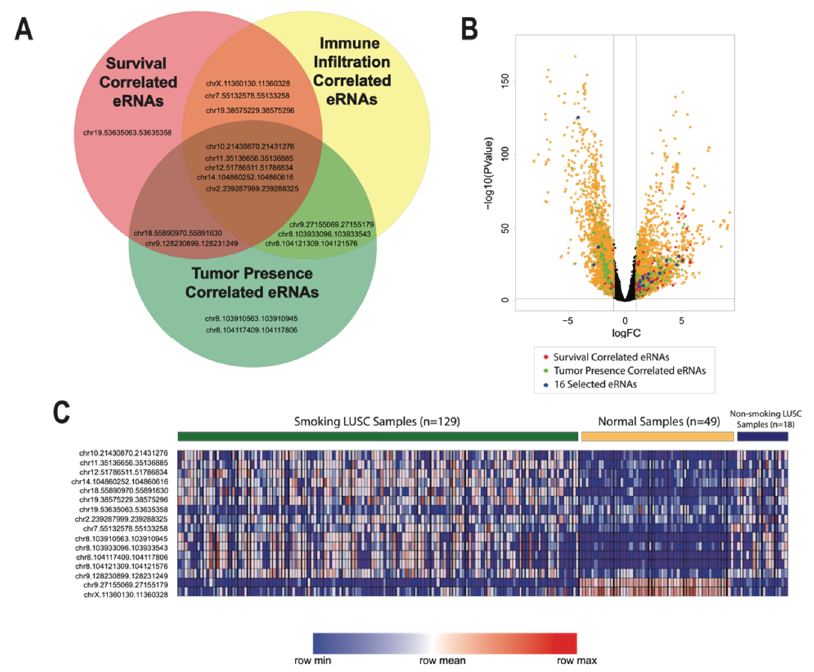
Figure 4. Identification and Analysis of 16 eRNAs identified to be critical to LUSC immune landscape and tumor phenotype. ( A ) Venn diagram summarizing the significant correlations of the selected 16 key eRNAs to patient survival, immune cell infiltration, and tumor status. Each of the 16 selected eRNAs has a high degree of association with various clinical and molecular measures of tumor severity, implicating their potential role in furthering LUSC pathogenesis and metastasis. ( B ) Volcano plot across all significantly dysregulated eRNAs illustrating the statistical significance versus the magnitude of change (log fold change) in survival-correlated eRNAs, tumor-presence-correlated eRNAs, and the identified 16 critical eRNAs. The 16 key eRNAs demonstrate both a high degree of statistical significance and magnitude of change in expression. ( C ) Associations between genomic alterations and eRNA expression in smoking-onset LUSC samples, nonsmoking-onset LUSC, and adjacent normal LUSC samples. Correlations were determined using the REVEALER algorithm ( p -value < 0.05 and CIC >